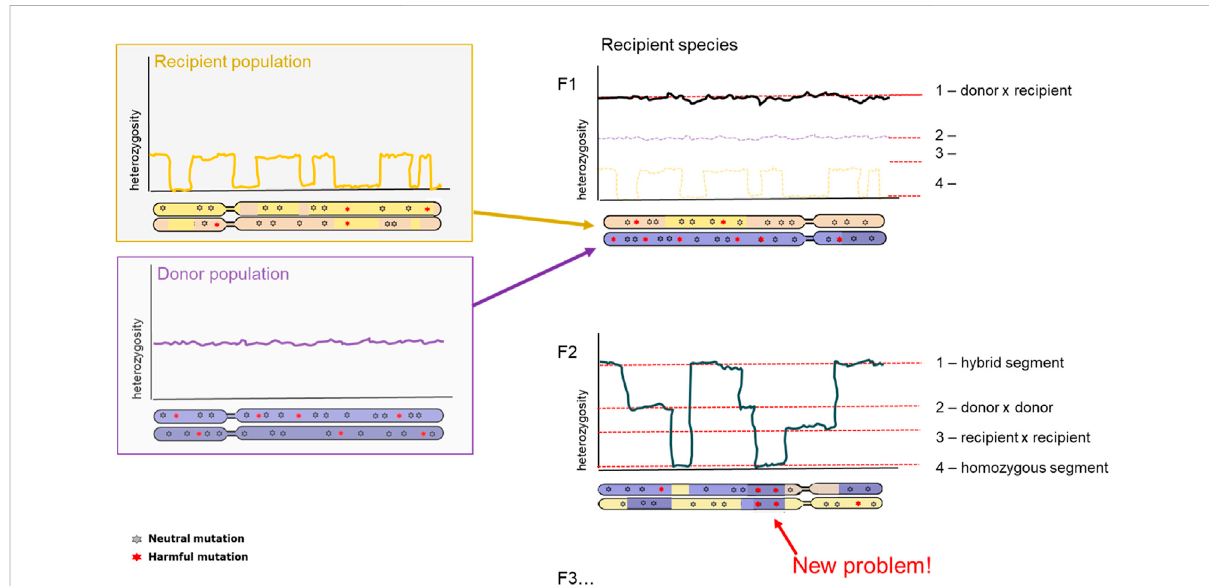
FIGURE 4 Diversity and genetic load after hybridization. Representation of chromosome-wide heterozygosity in an individual, sampled from the Donor population(top,purple);Recipient population(bottom,orange); andthe fi rstgenerationhybridoffspring(right panel).Firstgenerationhybrid(F1; top panel) and second generation hybrid (F2, bottom panel) are depicted. Genetic variants are indicated as grey (neutral) and red